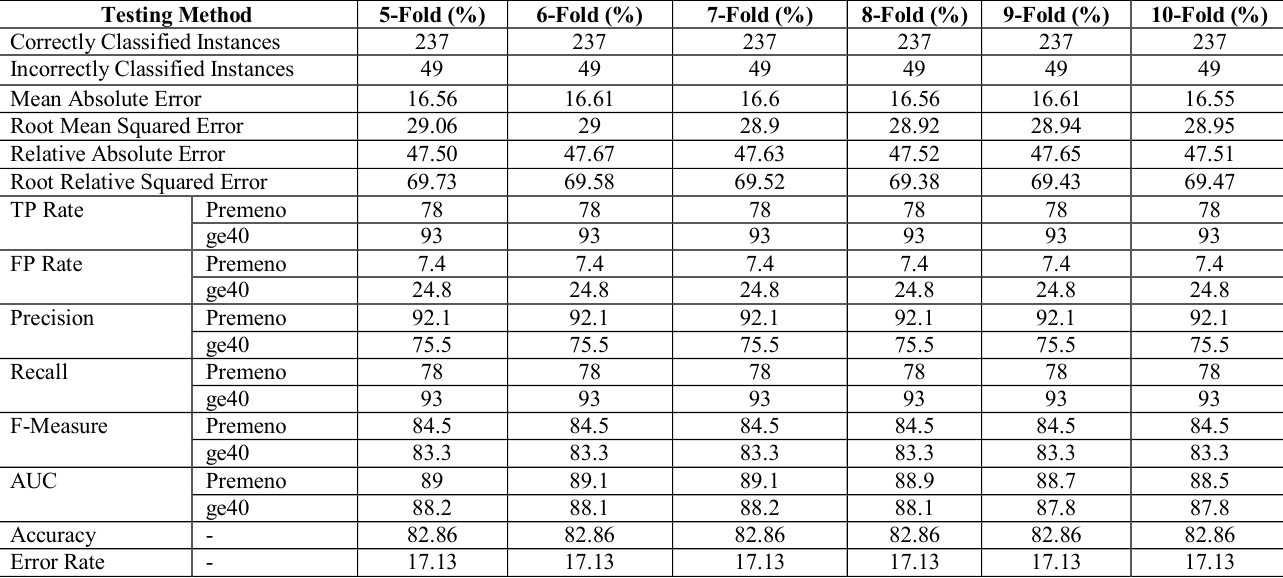
Table 4. Performance metrics of C4.5 using method II